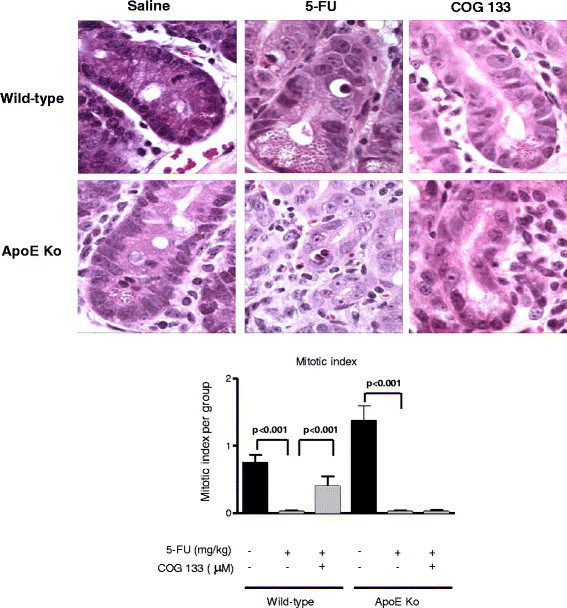
Mean mitotic index of the H&E stained-duodenal crypts (X1000) from C57BL6J ApoE knock-out and wild-type mice challenged by 5-FU-induced intestinal mucositis (450 mg/kg via i.p., single dose) and treated with the apoE mimetic peptide COG 133 (3 μM, via i.p., 12/12 h, vol. 10 μl/g) or 0.9% saline (i.p.). Values represent mean ± SEM and were analyzed by one-way ANOVA and Bonferroni. At least 10 crypts per animal were analyzed (n = 4 animals/group).Experimental mice were sacrificed on the fourth day post-challenge.